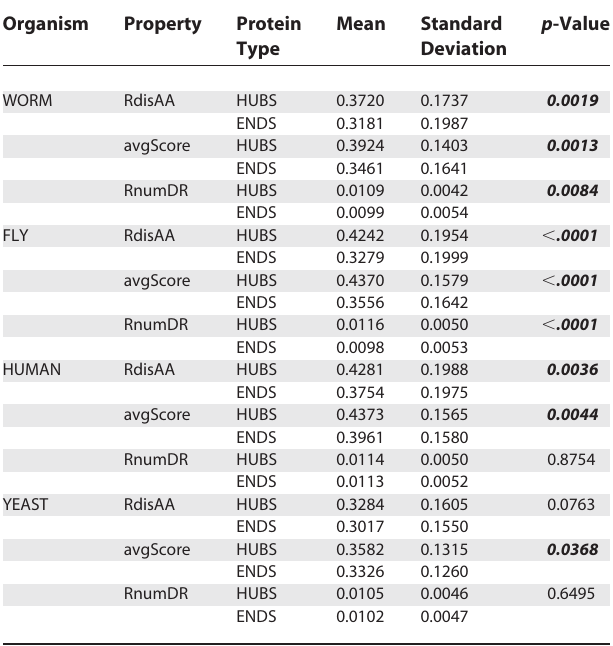
Table 2. Representative Disorder Attributes Calculated for Four Datasets